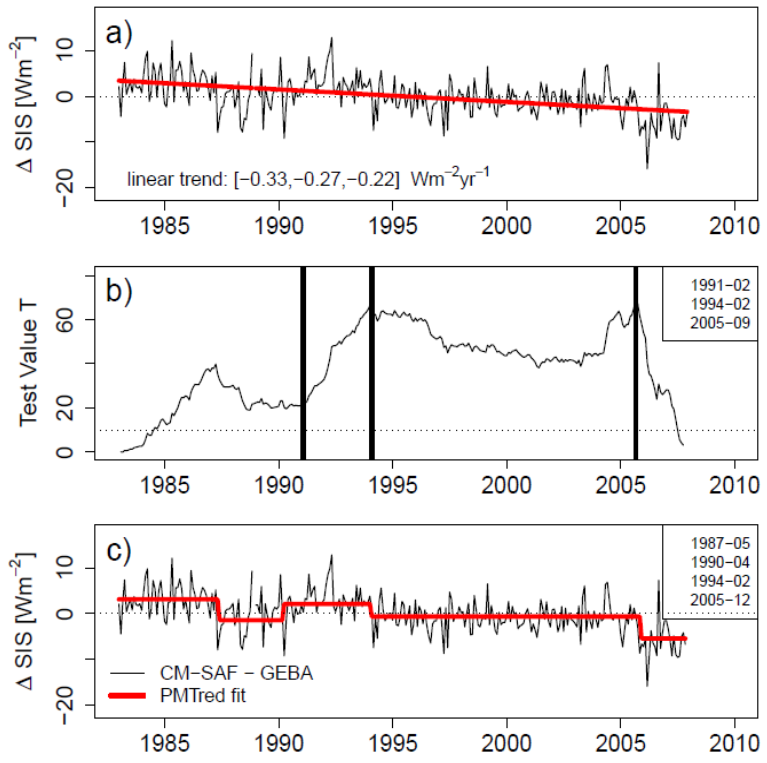
(black lines) and ( c ) the mean monthly CM SAF minus GEBA series including the PMT